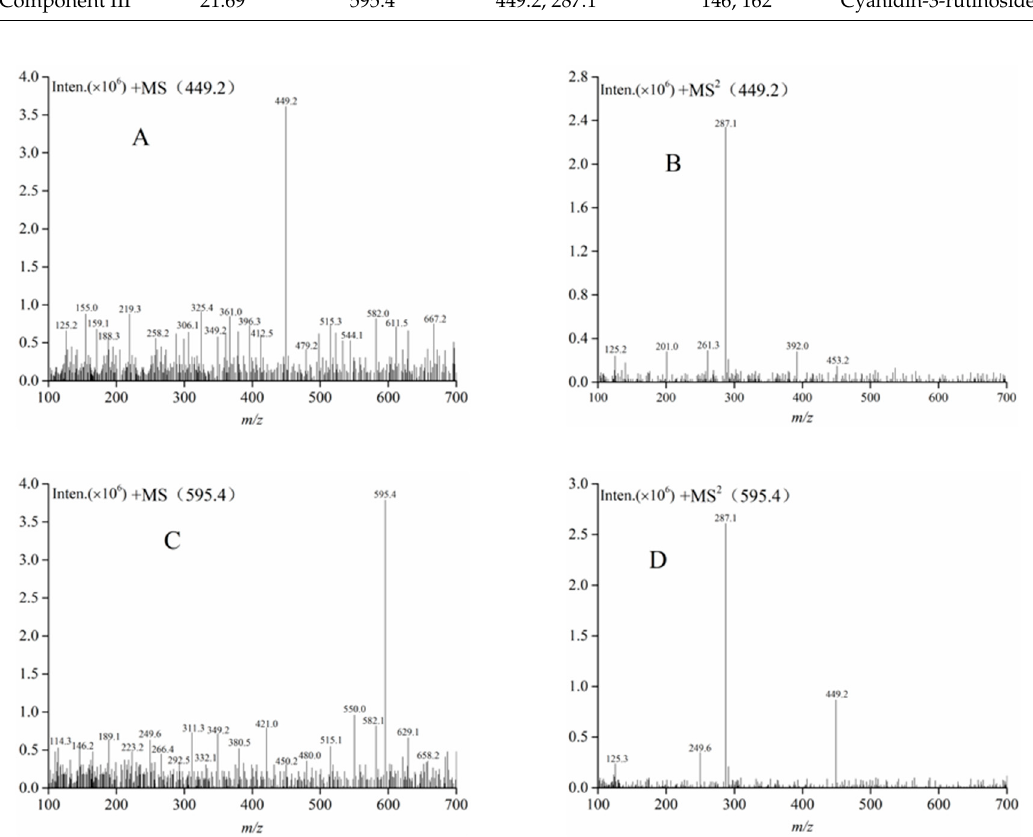
Figure 8. The MS spectra of component II ( A, B ) and component III ( C, D ).